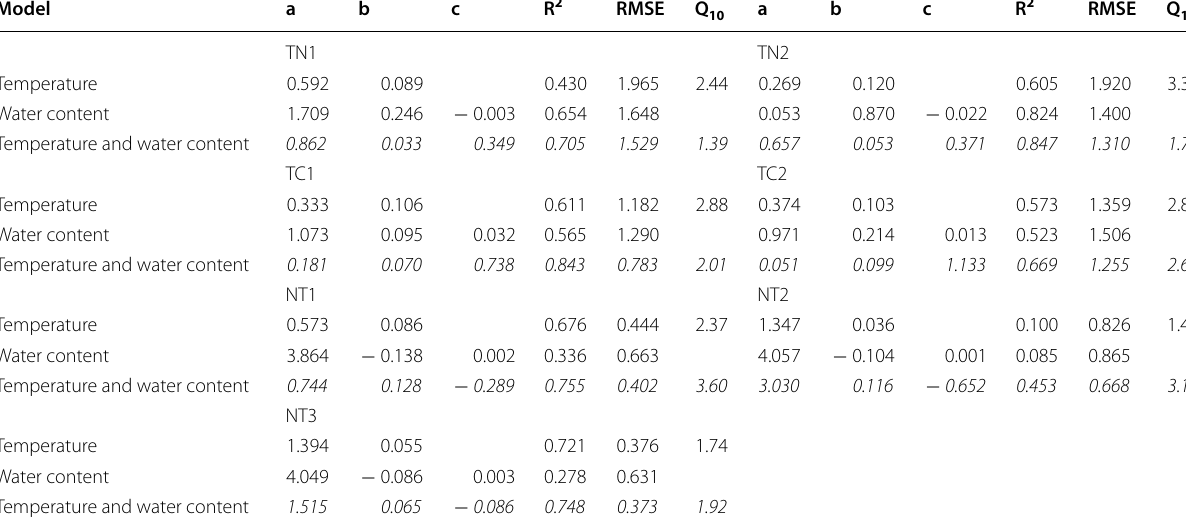
Italic text represents the best model with the highest R 2 and lowest RMSE, which was used for estimating annual soil respiration rates